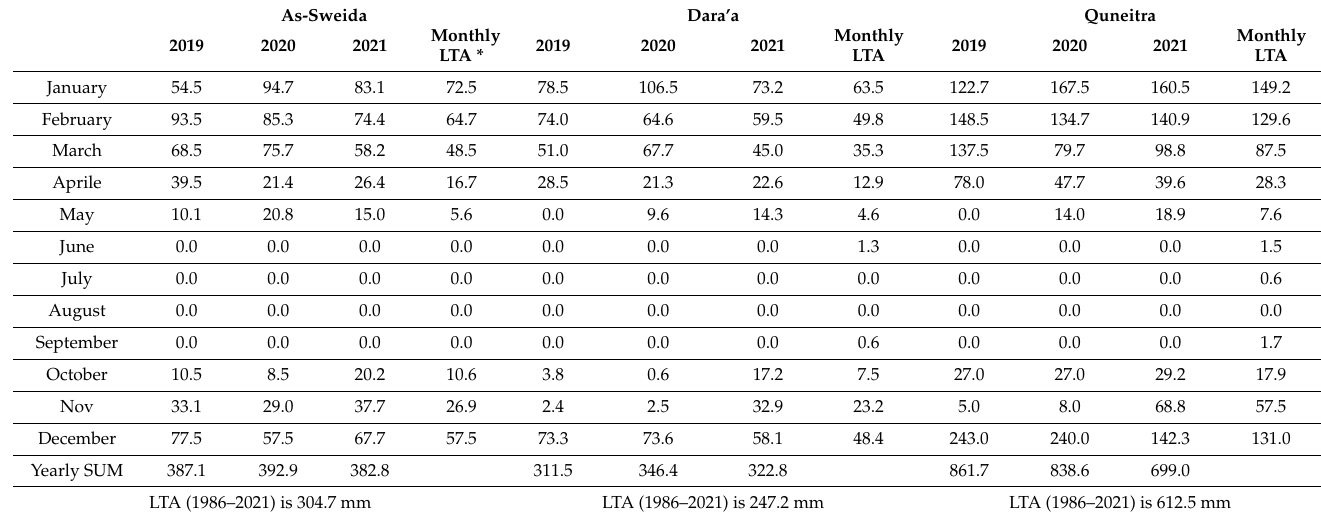
Table 1. Statistics of the rainfall in three agroclimatic stations in the Syrian part of Yarmouk River Basin (YRB) during the years of the crisis 2019–2021.